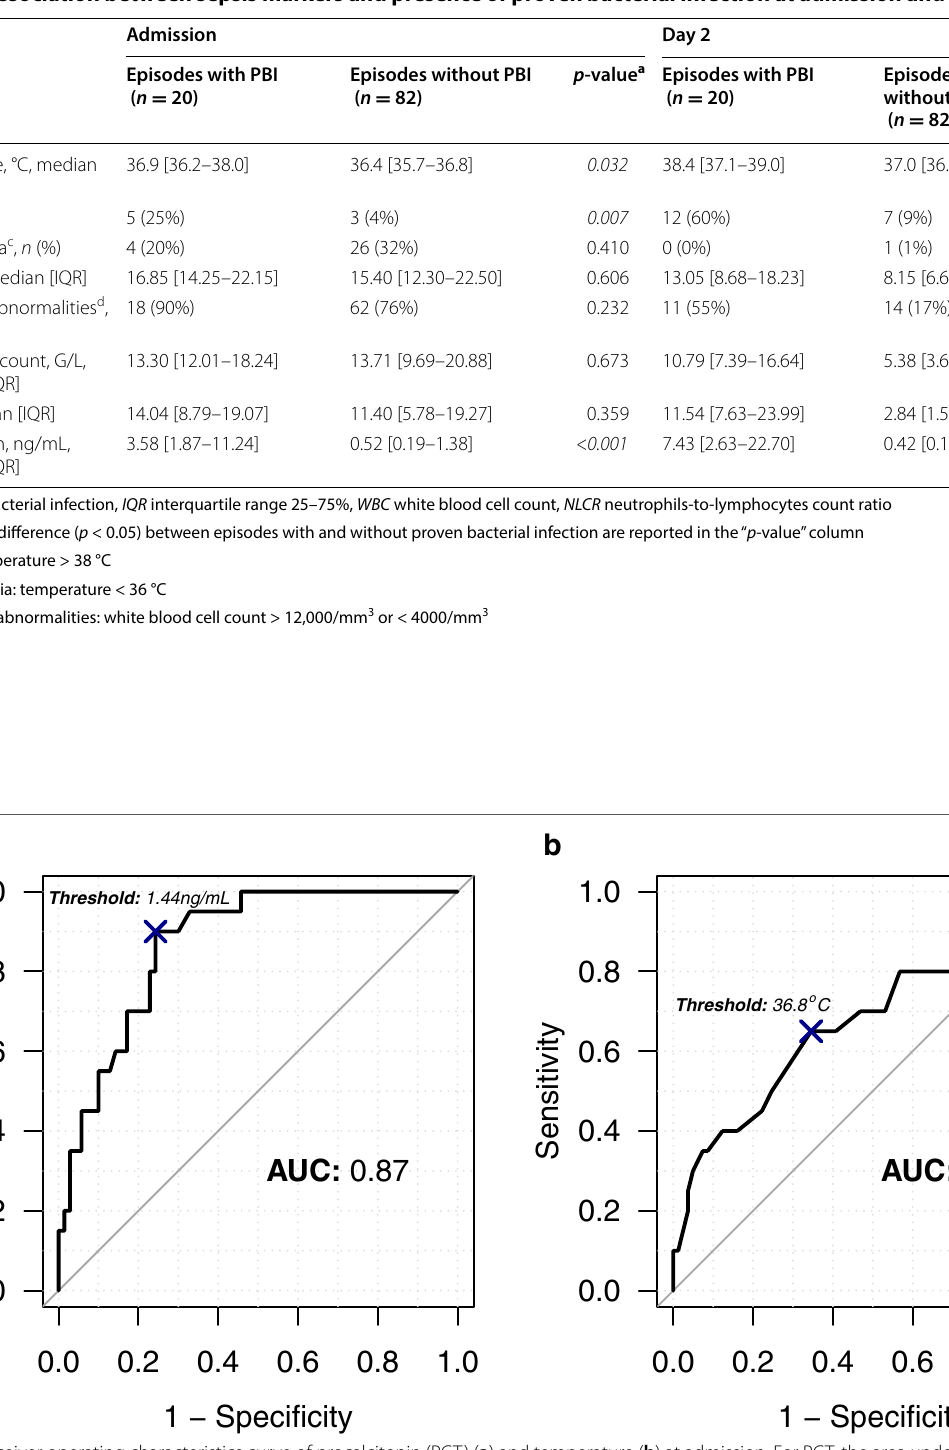
Table 2 Association between sepsis markers and presence of proven bacterial infection at admission and day 2